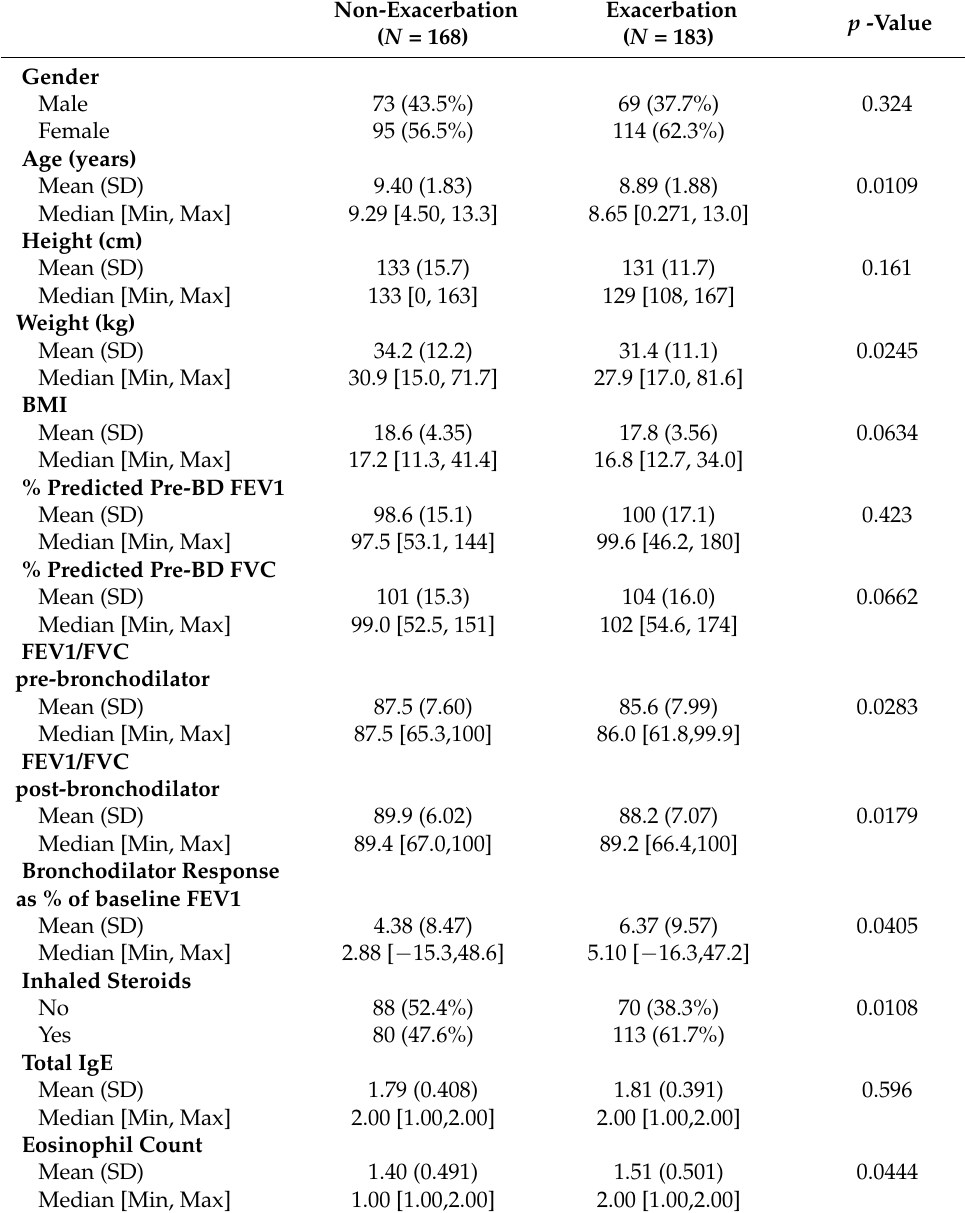
Table 1. Baseline Epidemiologic and Clinical Characteristics of the